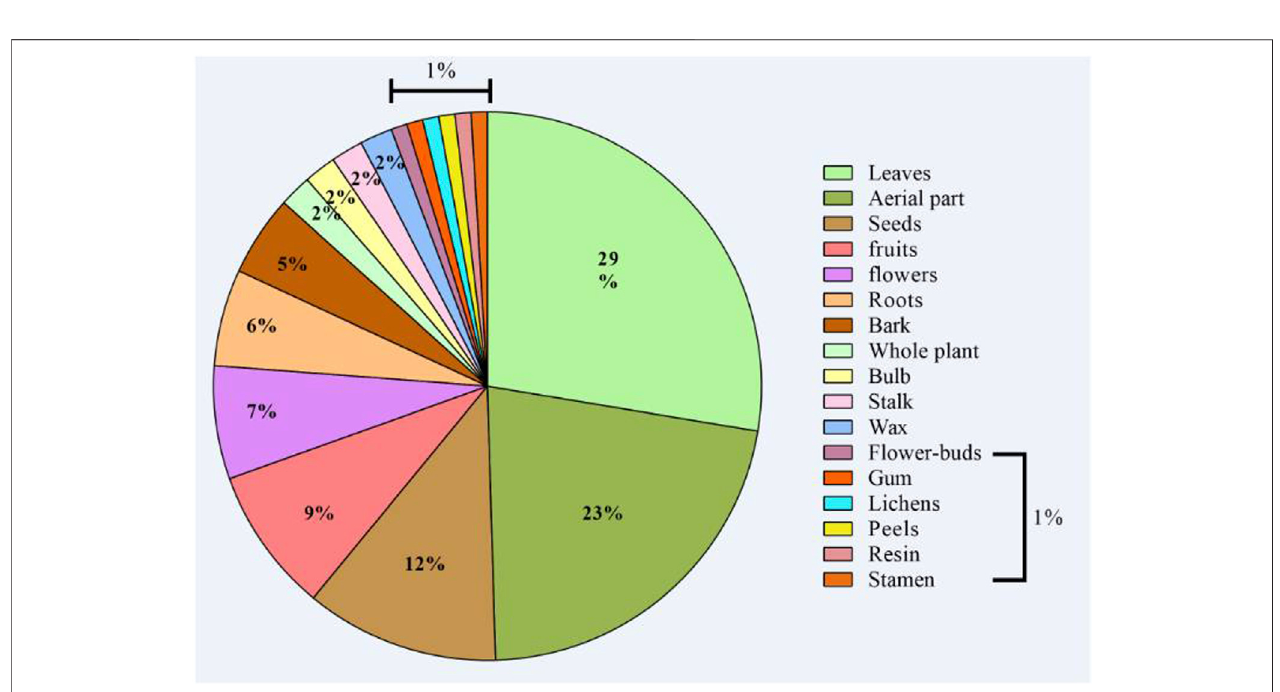
FIGURE 3 | Plants parts used by traditional